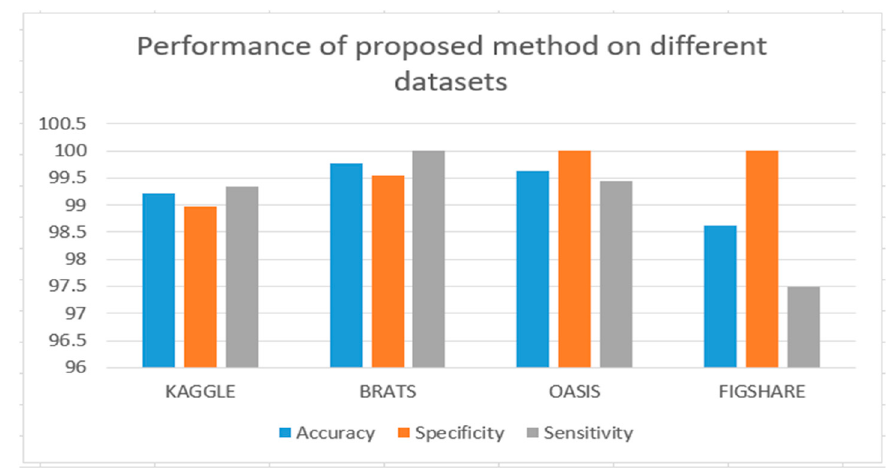
Figure 7. Performance of the proposed method on all datasets.